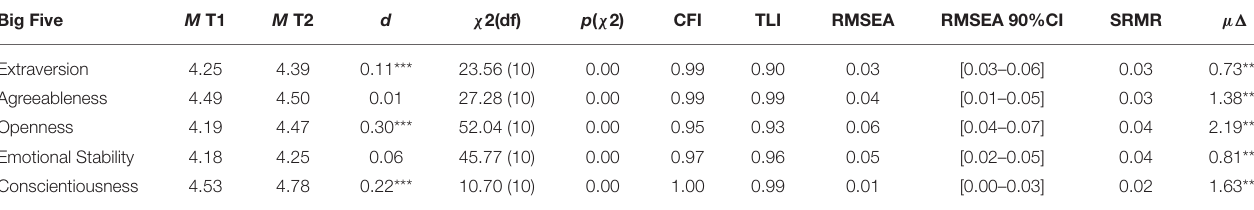
TABLE 2 | Big Five mean-level change from T1 to T2 with fit indices, n = 1,243. Big Five M T1 M T2 d χ 2(df) p ( χ 2) CFI TLI RMSEA RMSEA 90%CI SRMR µ1